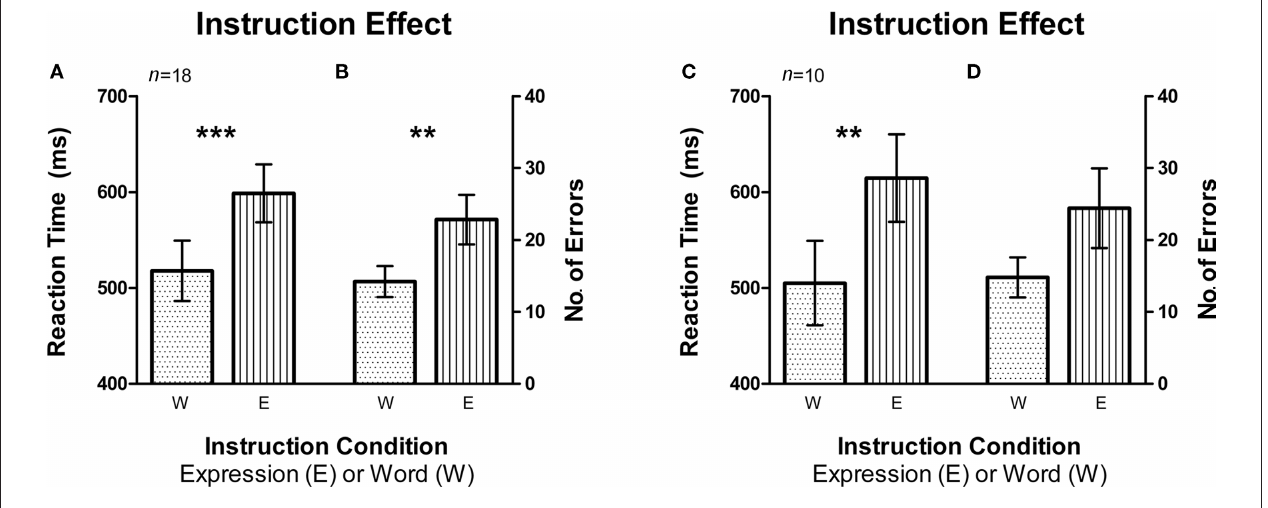
FIguRe 3 | Instruction effect depicting the automaticity of word reading compared to expression recognition. Error bars signify the standard error of mean (SEM). (A) Average reaction time (RT) was higher for the expression instruction condition compared to word instruction ( n = 18, fMRI and Behavioral subjects).